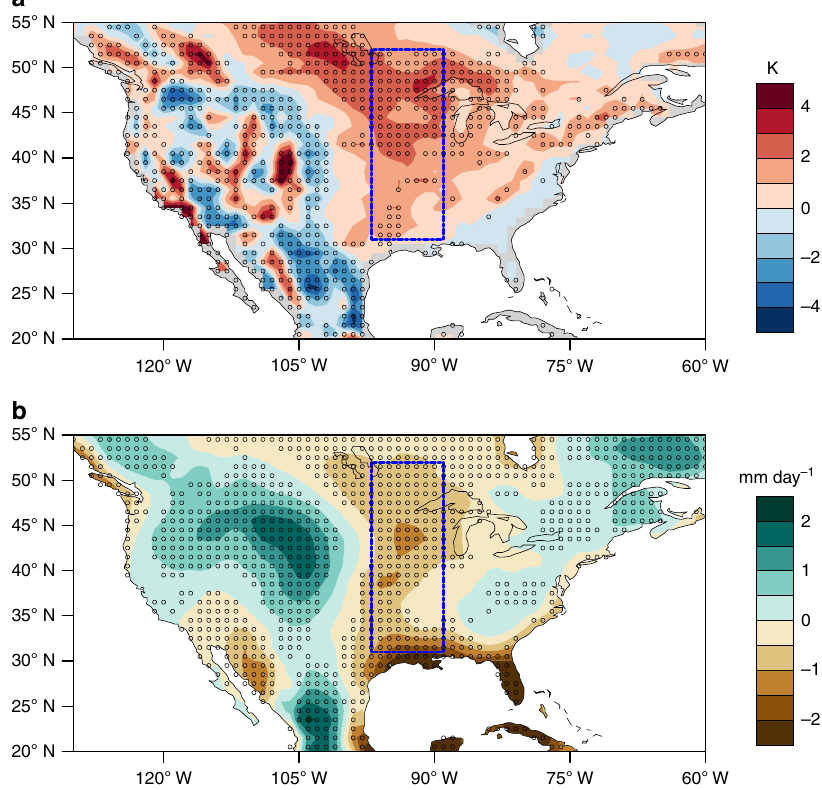
Fig. 1 Geographical biases of temperature and precipitation in CMIP5 models. a Multi-model mean of temperature biases and b precipitation biases in summer during 1979 – 2005 from 19 CMIP5 historical simulations. Regions where at least two thirds of the models (i.e., 13 out of 19 CMIP5 models) agree on the sign of the difference are marked with black circles. The blue rectangle (31 – 52° N, 262 – 271° E) indicates the central